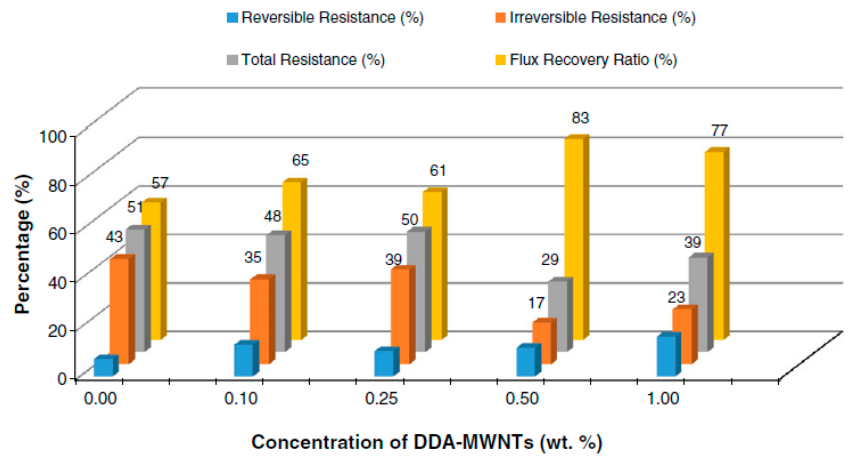
Figure 7. Fouling resistance and flux recovery of nanocomposite membrane. (Reproduced with permission after [51]). Coatings 2020 , 10 , 609